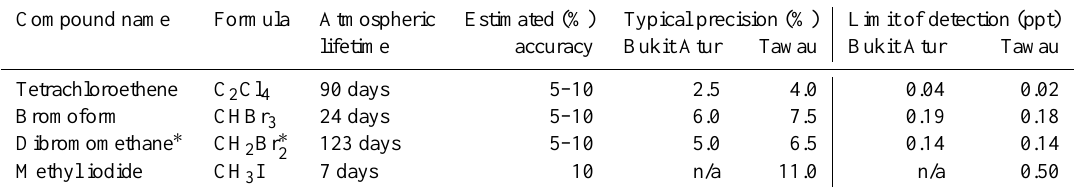
Table 1. Dirac target compounds and measurement performance at Bukit Atur and Tawau. Atmospheric lifetimes are taken from Tables 1–4 in Montzka and Reimann (2011); the lifetime value for CH 2 Br ∗ is actually that for CH 2 Br 2 ; estimated accuracies are ± 1 standard deviation; 2 typical measurement precisions are ± 1 standard deviation of six calibration chromatograms made in a single day; limit of detection is based on a signal-to-noise ratio of 10:1; and n/a means no data available.